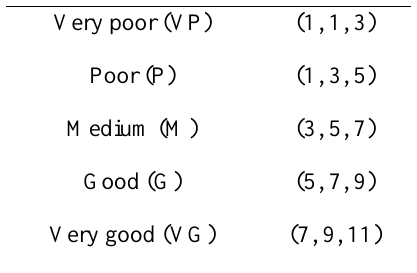
Table 5. Fuzzy Linguistic